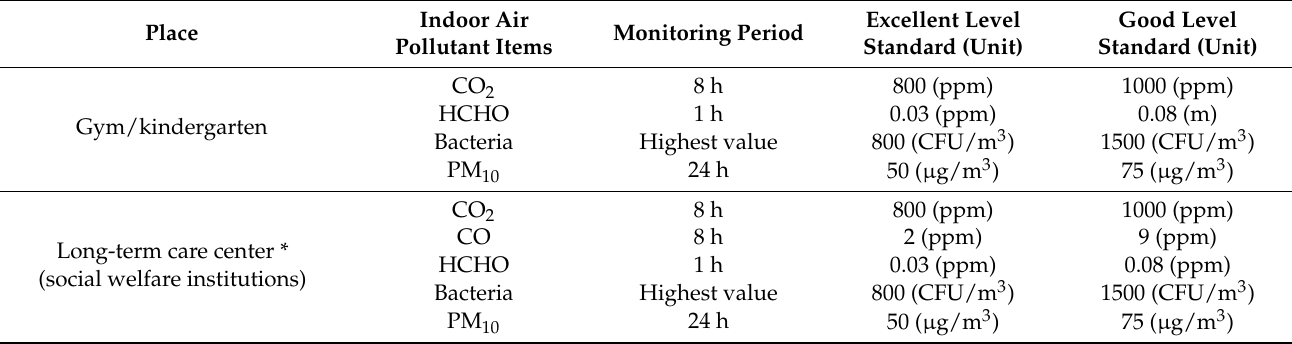
Table 4. Selected cases of the IAQ certification standard in Taiwan.